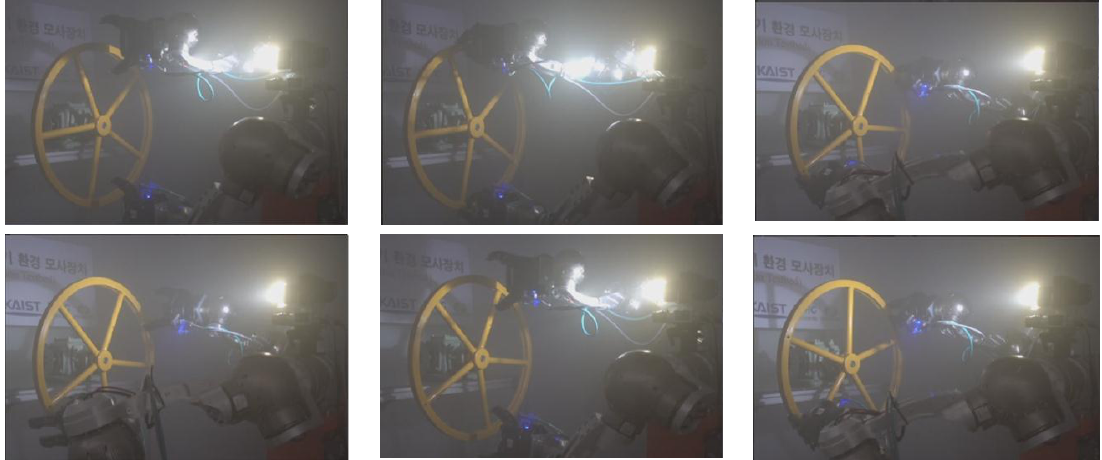
Figure 13. The snapshot of the robot turning the valve in dense fog condition.